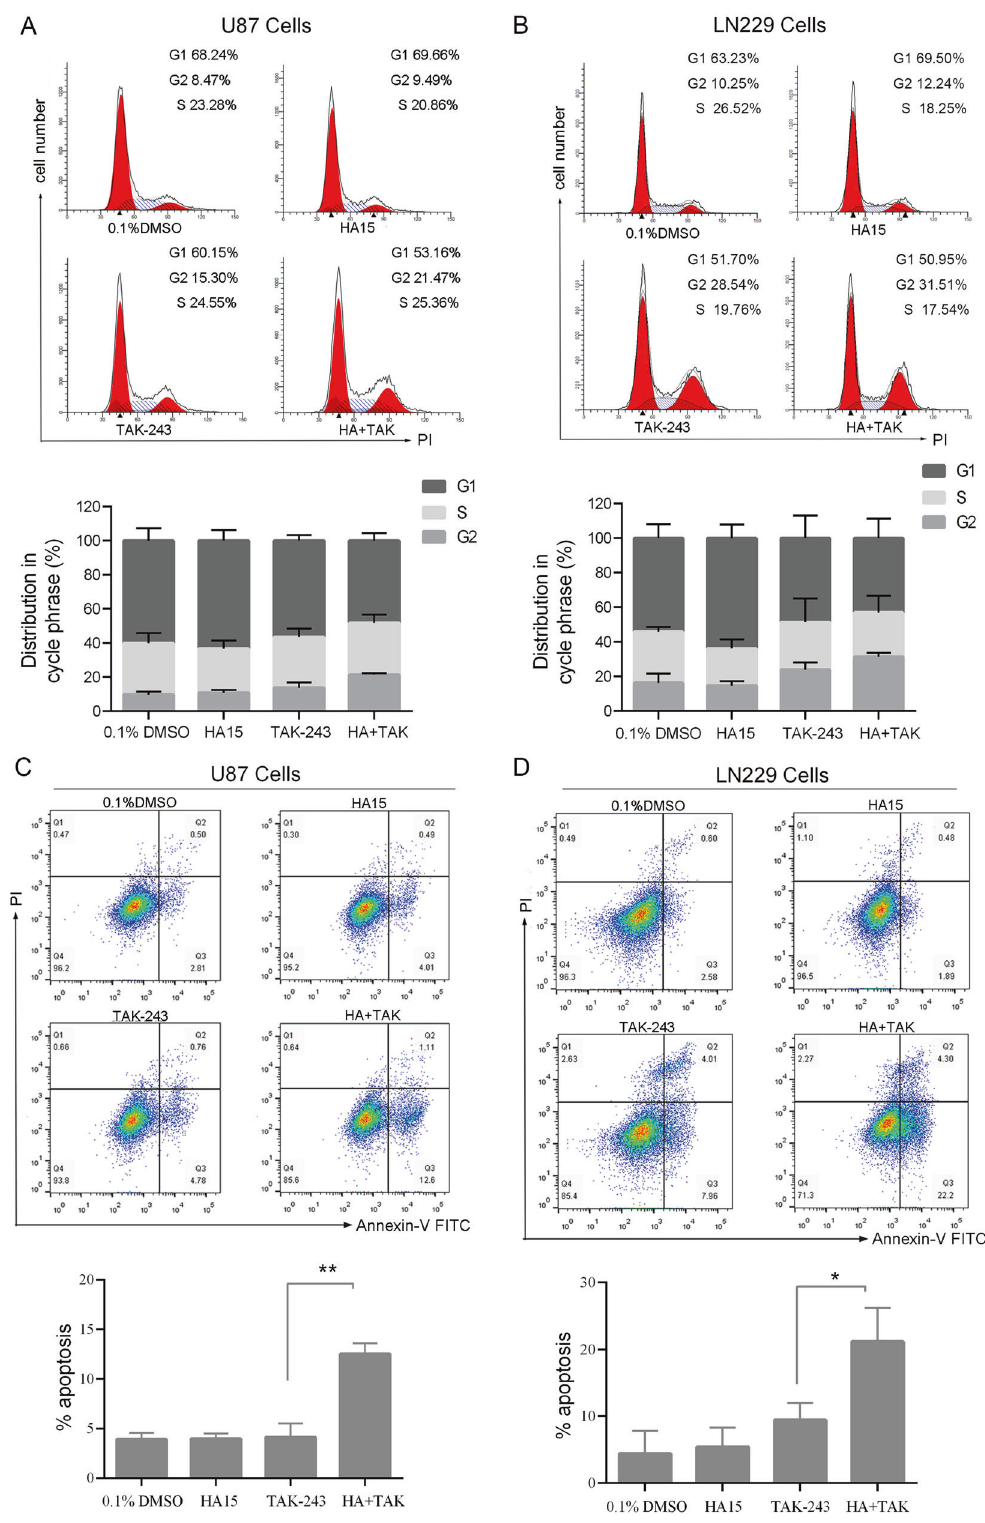
Fig. 3 HA15 enhanced TAK-243-induced cell cycle arrest and cell apoptosis. A , B Representative data of the cell cycle analysis of TAK-243 and/or HA15-treated groups. U87 and LN229 cells were treated with TAK-243 (100 nM) and/or HA15 (10 μΜ ) for 24 h. Cell cycle pro fi le was evaluated using fl ow cytometry. Quantitative analysis of cell cycle phase distribution in the control group and the HA15 and/or TAK-243- treated groups. C , D U87 and LN229 cells were treated with TAK-243 (100 nM) and/or HA15 (10 μΜ ) for 24 h, and were stained with Annexin V/ PI. Apoptosis was evaluated by fl ow cytometry. The total proportion of Annexin V-positive (early apoptotic) cells and Annexin V/PI-stained double positive (late apoptotic) cells was counted as apoptotic to prepare the bar graph. The data from three independent experiments were presented as the means ± SD (* P < 0.05, ** P < 0.01).